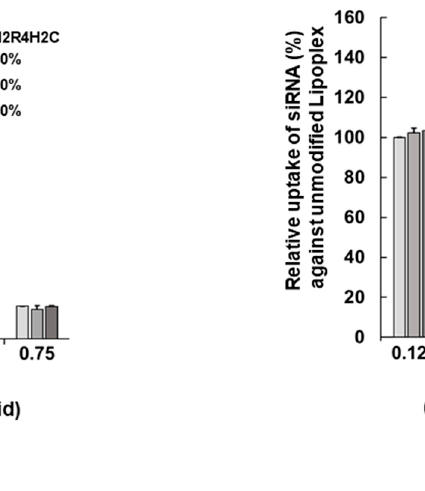
Figure 1. Effects of the molar ratio of DOTAP in cationic-LP and peptide modification on the intracellular uptake of STR-CH2R4H2C-LP-siRNA lipoplexes. ( a ) ATTO-labeled liposome and ( b ) FAM-siRNA cellular uptake (%) in RPE cells. STR-CH2R4H2C-cationic-LP-siRNA lipoplexes with different molar ratios of DOTAP (0.125–0.750 µ mol per 3 µ mol of total lipid in cationic-LP) and STR-CH2R4H2C (0.0–2.0 mol%) were transfected into RPE cells (2.0 × 10 5 cells) in serum-free DMEM for 4 h (ATTO-DOPE 0.2 µ M, FAM-siRNA 0.158 µ M). The mean fluorescence intensity (MFI) was measured by flow cytometry at 10,000 events per cell. Each value represents the relative percent to each unmodified control lipoplex. Data represent the mean ± SD ( n = 3). * p < 0.05, ** p < 0.01. The 2.0 mol% STR-CH2R4H2C modification to DOTAP0.250-LP significantly